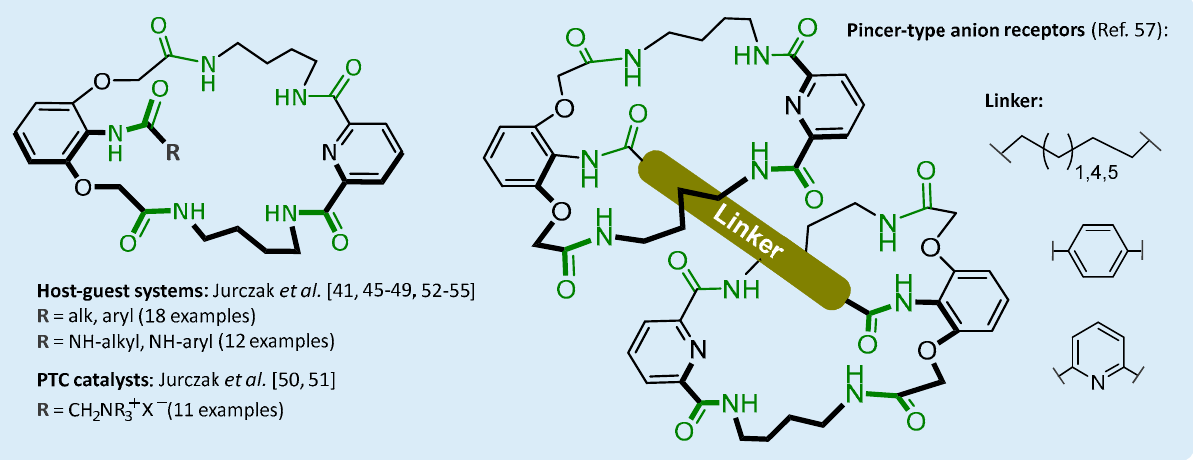
Figure 1. Examples of molecular structures and applications of polyamidic macrocyclic systems based on the unclosed cryptand platform; hydrogen bond donor and acceptor groups are colored in green.